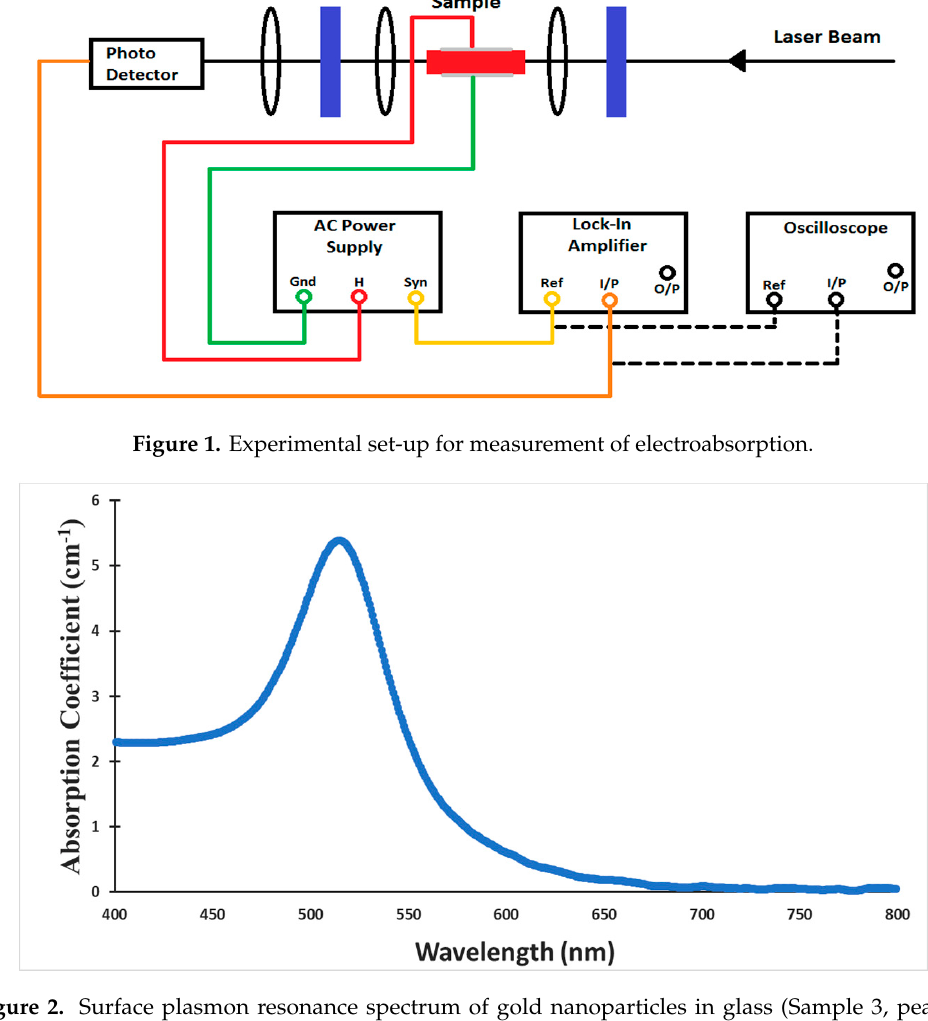
Figure 2. Surface plasmon resonance spectrum of gold nanoparticles in glass (Sample 3, peak at ~520 nm). The particle diameter ~15 nm.